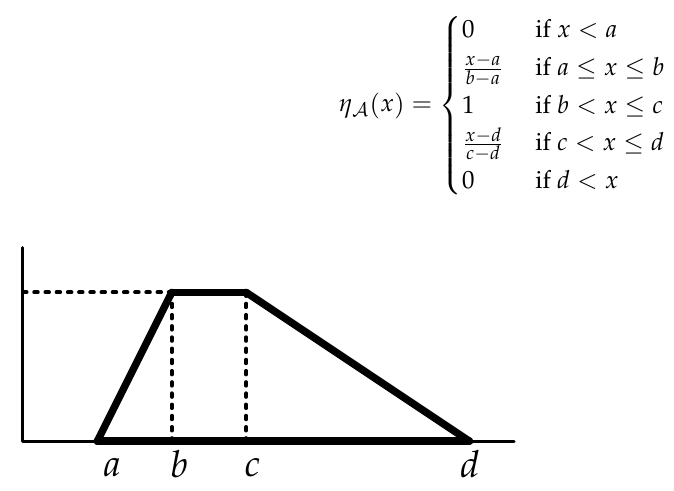
Figure 1. Graph G = ( V , E ) and fuzzy linguistic